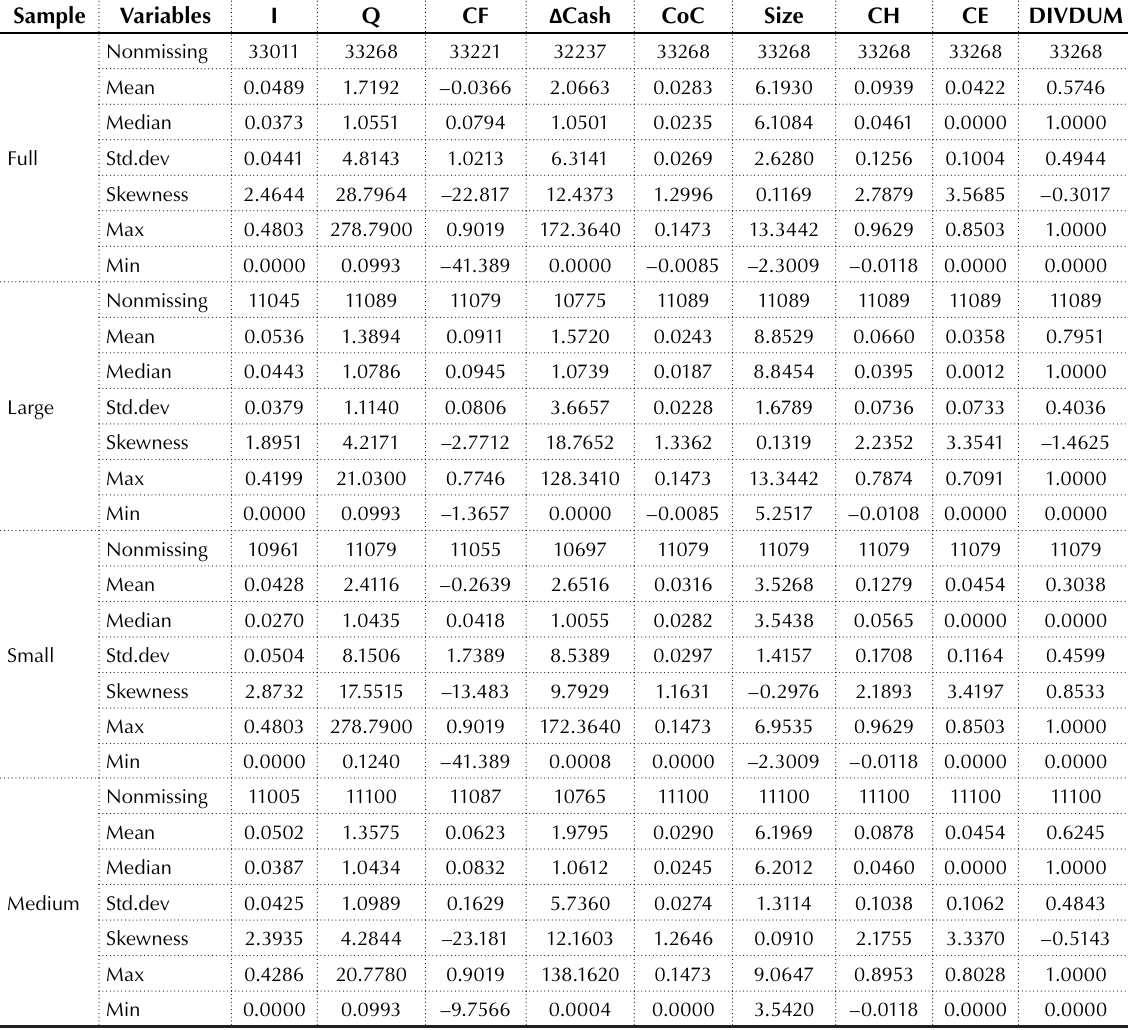
Table 2. Descriptive statistics of the full sample and the size terciles